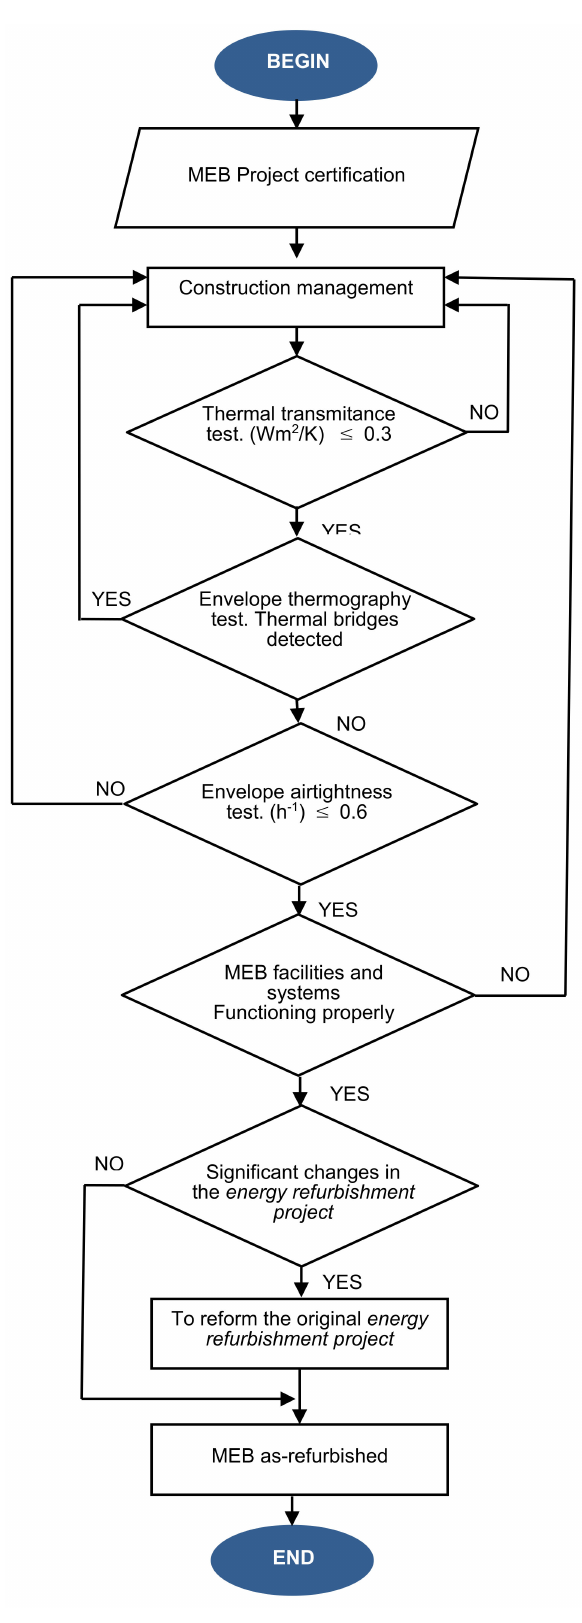
Figure 3. Refurbishment works management